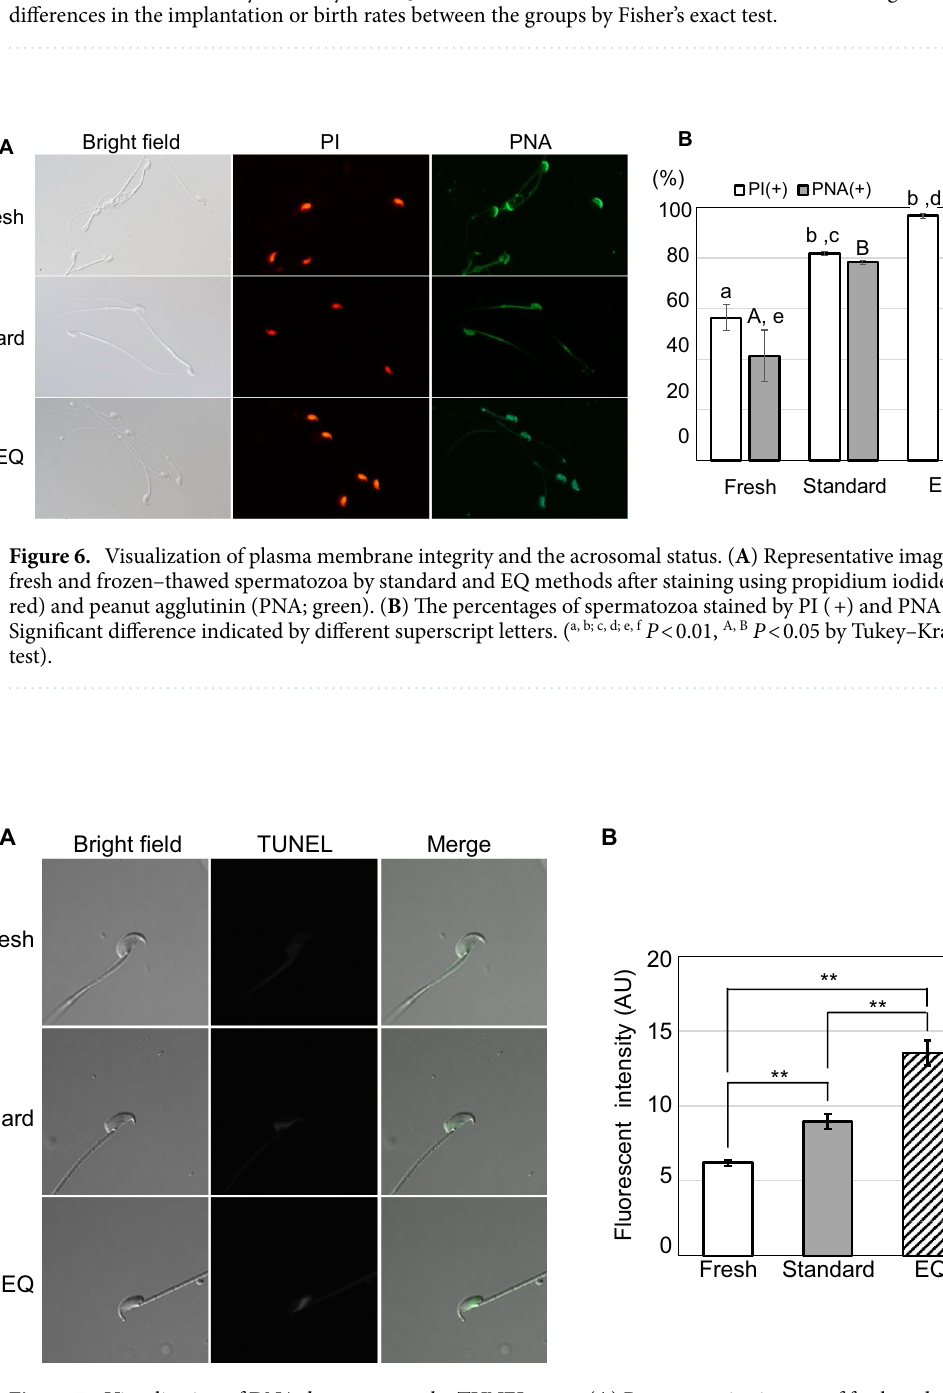
Figure 7. Visualization of DNA damage status by TUNEL assay. ( A ) Representative images of fresh and frozen–thawed spermatozoa cryopreserved by standard or EQ methods after TUNEL staining. ( B ) The relative fluorescent intensities of TUNEL signals (fresh, n = 93; standard method, n = 96; EQ, n = 83). The asterisks indicate significant differences between groups (** P < 0.01 by Tukey–Kramer